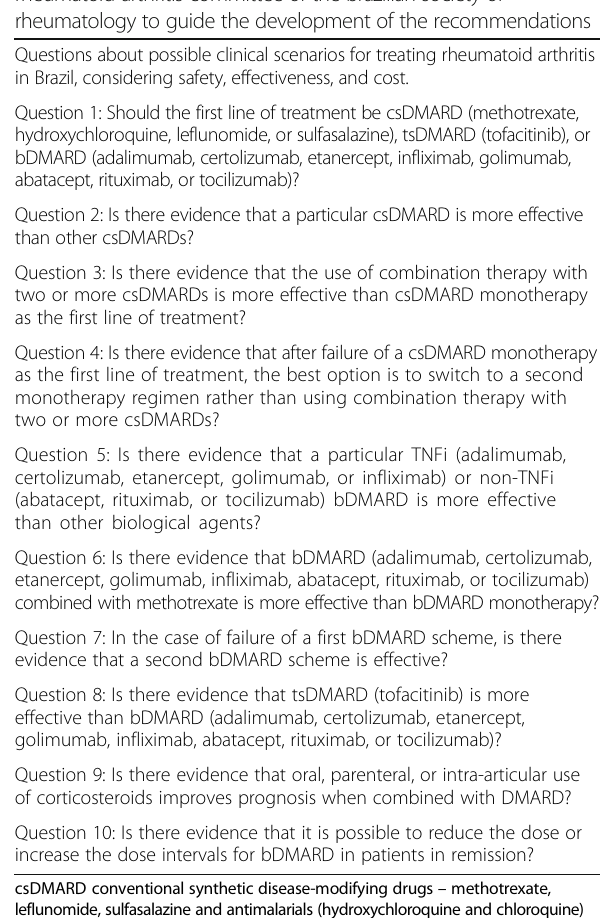
Table 1 Questions based on clinical scenarios, selected by the rheumatoid arthritis committee of the brazilian society of rheumatology to guide the development of the